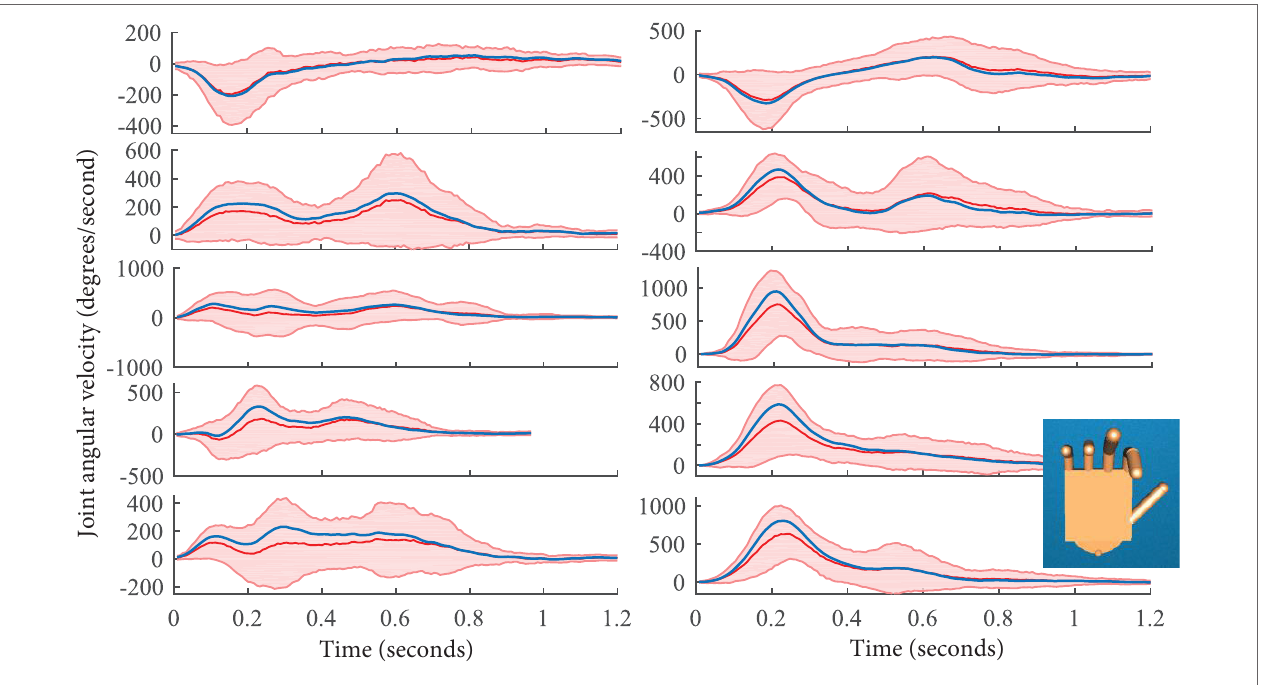
FigUre 4 | The red line shows the averaged joint movement across all 25 grasps in one repetition . SD is provided by the red shaded region. Metacarpophalangeal (MCP) and proximal interphalangeal (PIP) joints of the thumb (T), index (I), middle (M), ring (R), and pinky (P) are shown on the left and right, respectively. To show how the first synergy compares to the average movement, synergy 1 of this particular subject is overlaid by the blue line. Note that this synergy has been multiplied by a gain so that both the red and blue traces match for visual purposes only. The end posture of this synergy is shown on the bottom right. This is considered a postural synergy.